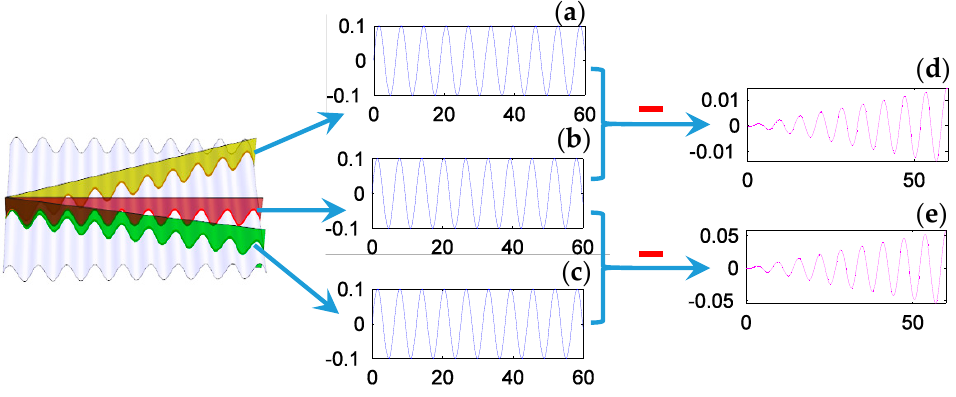
Figure 2. Surface roughness measuring direction influences of ( a ) profile when incline is 8°; ( b ) profile in ideal measuring direction; ( c ) profile when incline is 4°; ( d ) profile error when incline is 8° and ( e ) profile error when incline is 4°.